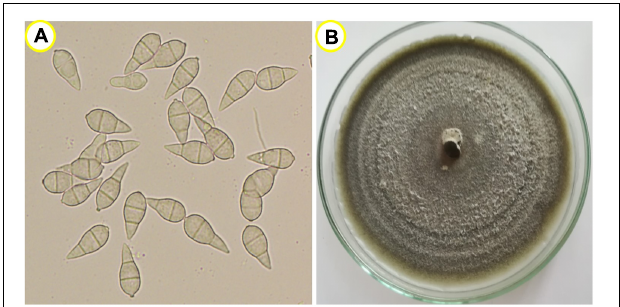
FIGURE 3 | (A) Pyriform two-septate hyaline to pale, gray-colored asexual conidia under compound microscope (magnification 400 × ) and (B) dark gray-colored colony of the fungus grown on potato dextrose agar (PDA)